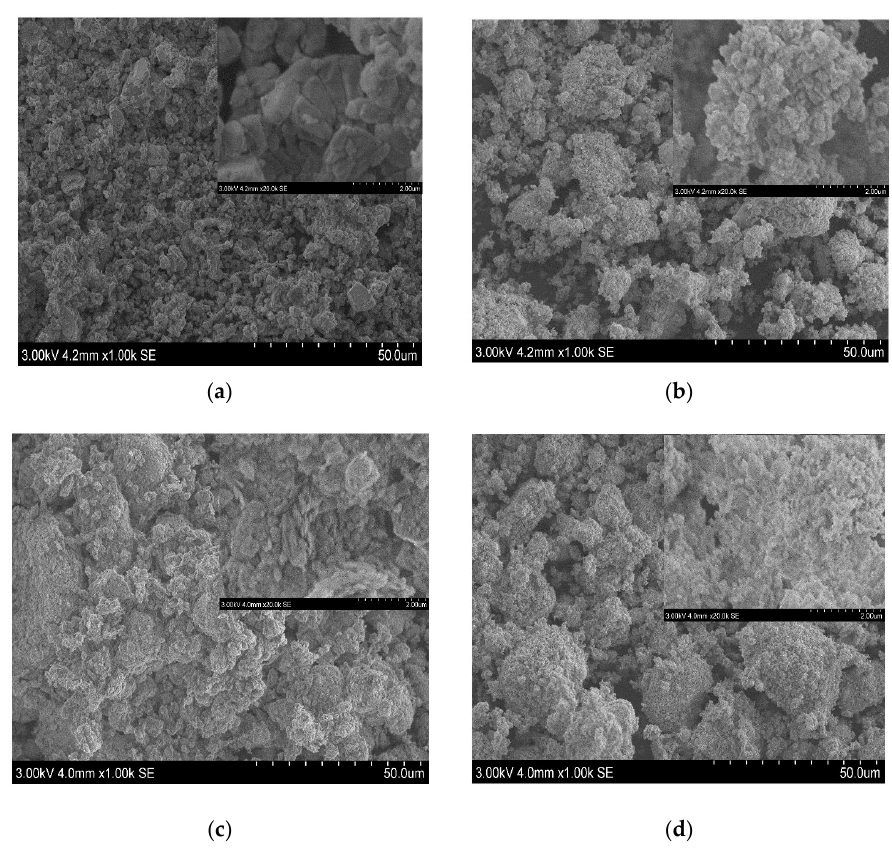
Figure 12. SEM images of: ( a ) raw limestone, ( b ) raw kaolinite, ( c ) clinker A, ( d ) clinker B.